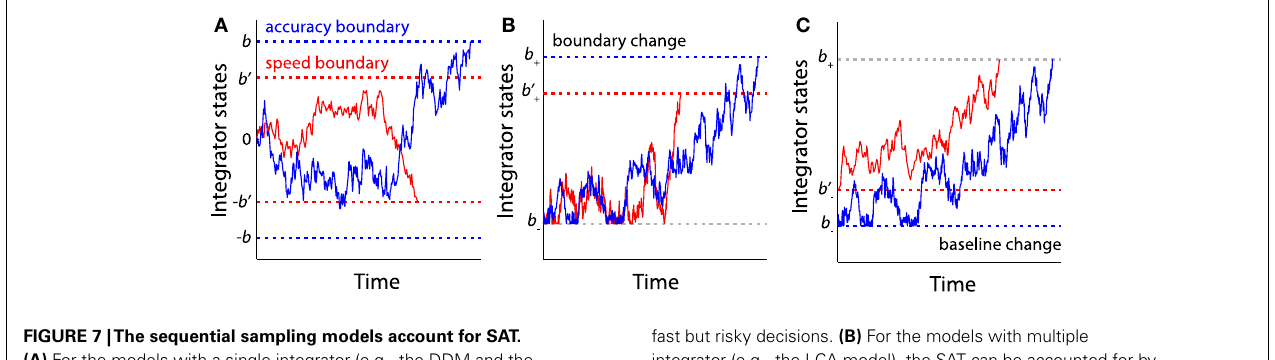
FIGURE 7 |The sequential sampling models account for SAT. (A) For the models with a single integrator (e.g., the DDM and the OU model), increasing the distance between two boundaries (blue boundaries ± b ) leads to slow but accurate decisions, while decreasing the boundary distance (red boundaries ± b ’) leads to